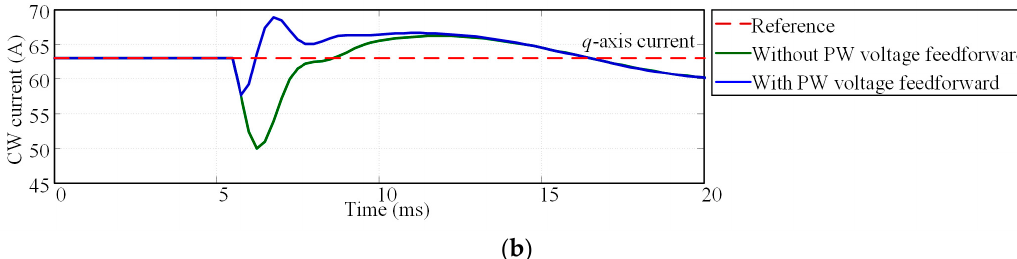
Figure 8. Dynamic responses of the CW currents at 500 rpm when the PW voltages symmetrically sag (Measure (solid); reference (dashed)). ( a ) Waveforms within 200 ms; ( b ) zoom-in waveforms within 20 ms.